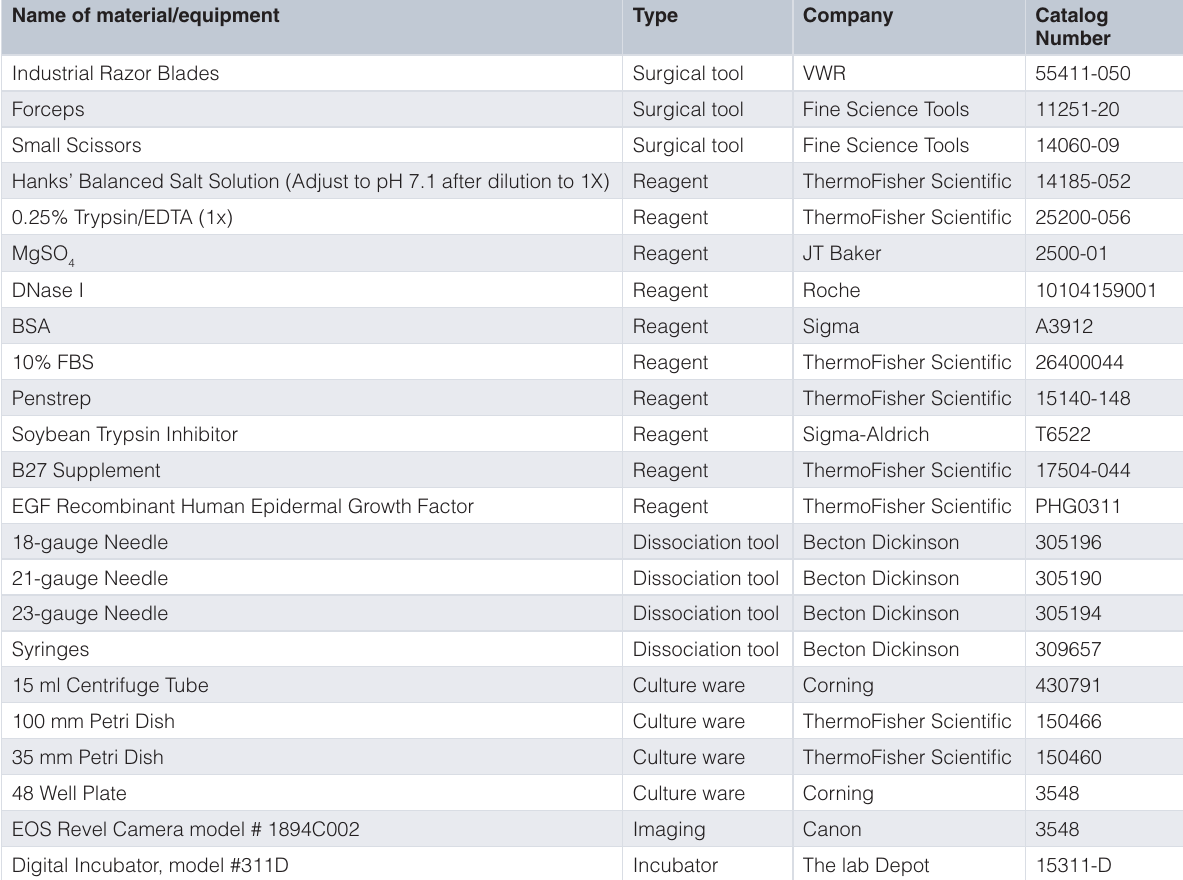
Table 1. Equipment, reagents, and catalog information. Name of